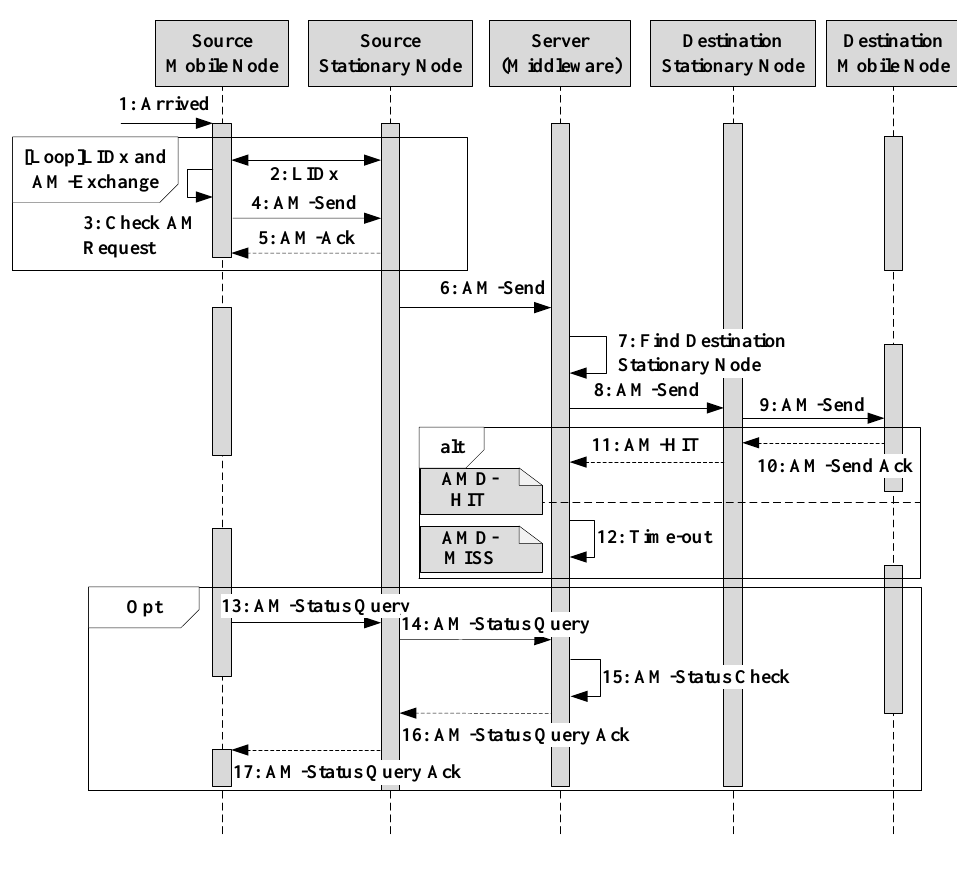
Figure 7. Complete LAMD sequence